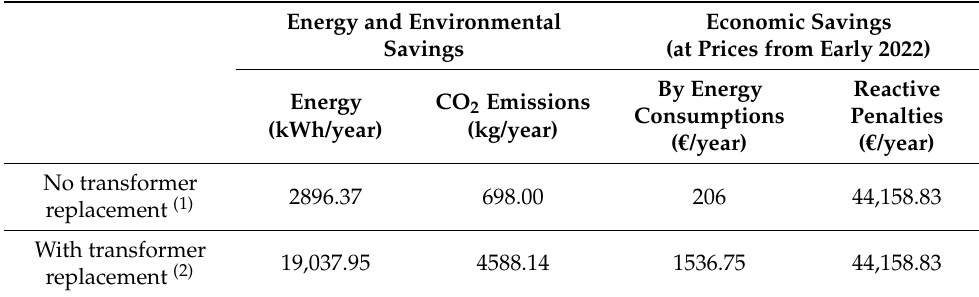
Table 15. Summary of energy, emissions and economic savings in the industrial transformation center: (1) Optimizing only the operation of the capacitor banks and (2) replacing the inefficient transformer with an efficient one, with optimization of the